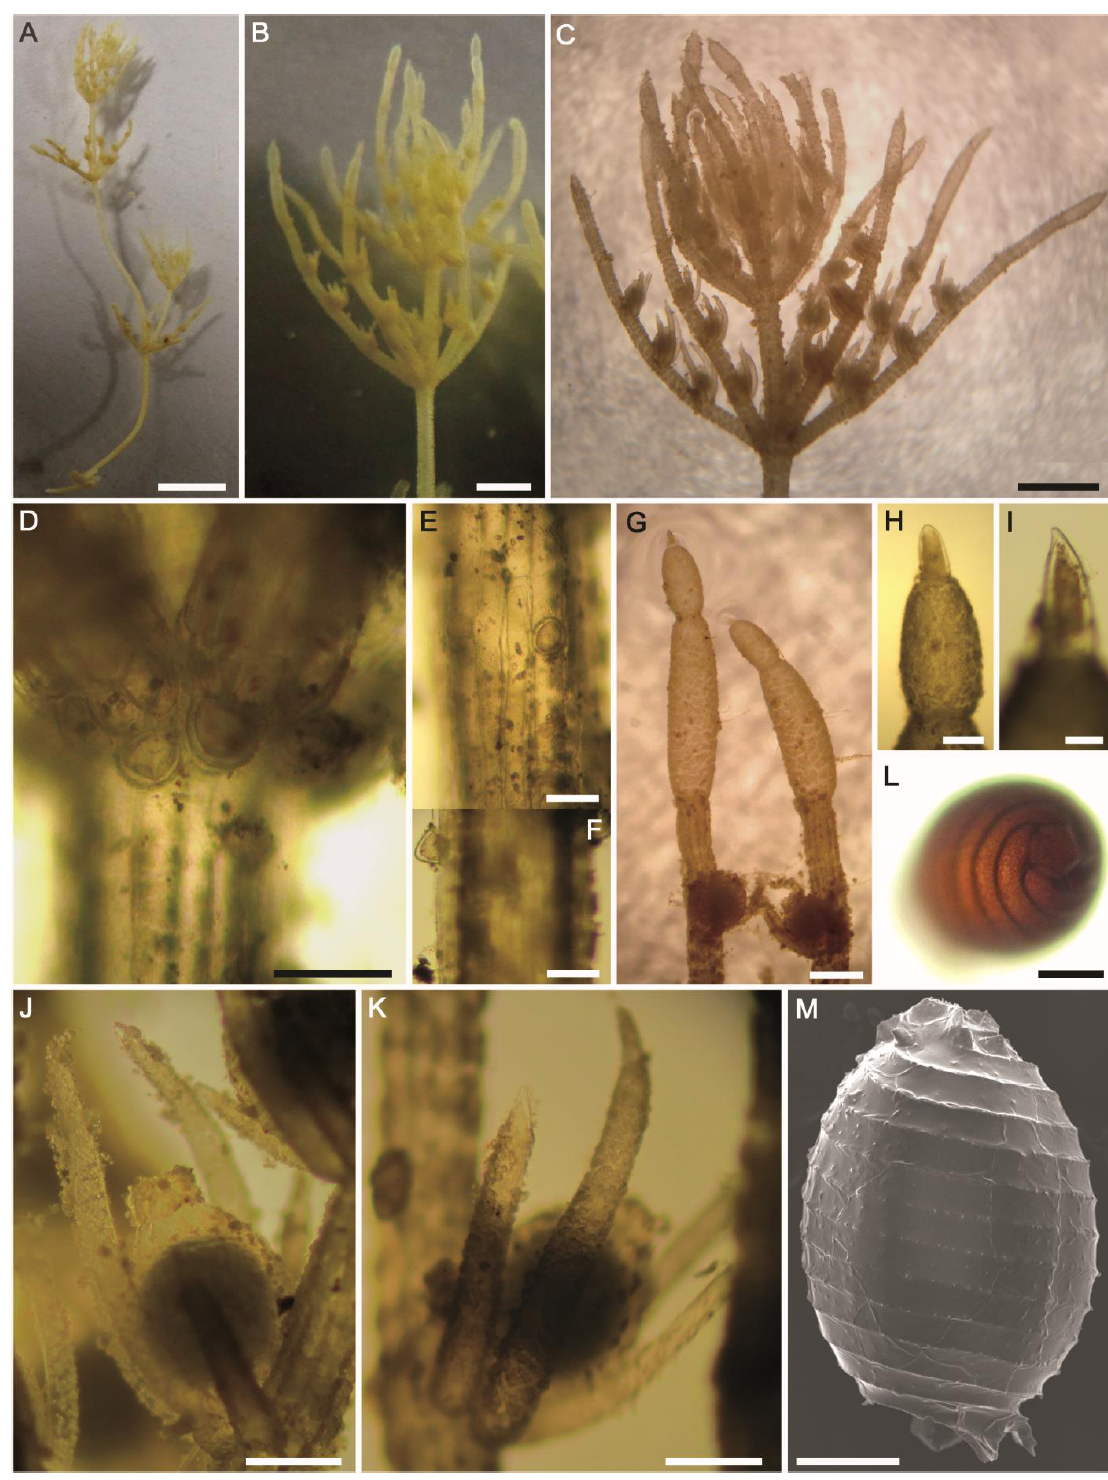
Figure 10. Morphotaxonomic features of Chara tomentosa found in a shallow marsh in the El-Dakhla Oasis (the Western Desert of Egypt): ( A ) macroscopic habitus; ( B , C ) whorls of branchlets of female plant; ( D ) axial node of young plant; ( E , F ) stem cortex and spine-cells; ( G ) branchlets of female plant with 2 inflated penultimate cells; ( H , I ) terminal branchlet cells; ( J , K ) nodes of branchlets with oogonia; ( L ) apical view of oospore; ( M ) SEM of oospore showing slightly flanged ridges, smooth ornamentation of fossae with irregularly small patterned projections, and basal claws. Scale bars: ( A ) = 1 cm; ( B , C ) = 2 mm; ( G ) = 500 μm ; ( D , H , J , K ) = 200 μm ; ( E , F , L , M ) = 100 μm ; ( I ) = 50 μm .